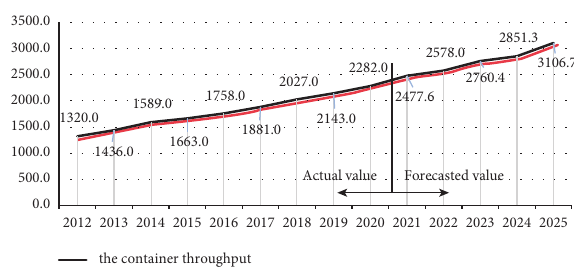
Figure 6: The container throughput developing trend (unit: